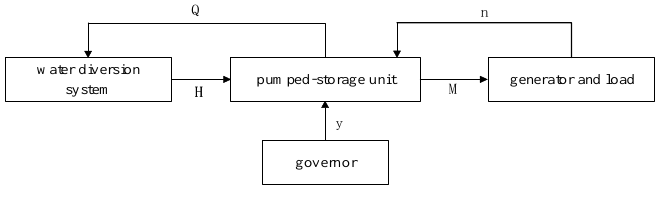
Figure 1. The regulating system model of pumped storage unit.